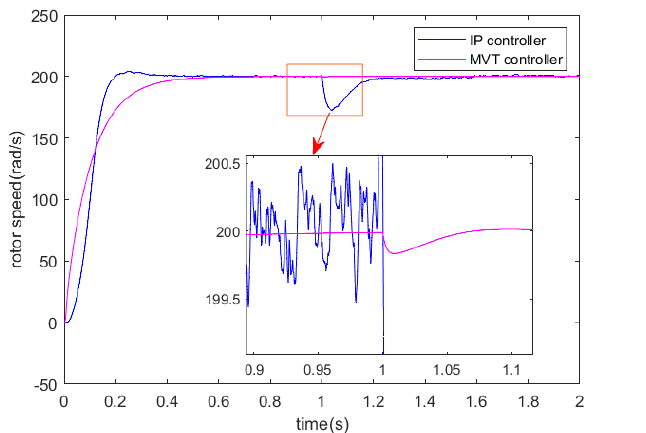
Figure 5. Rotor speed responses under two